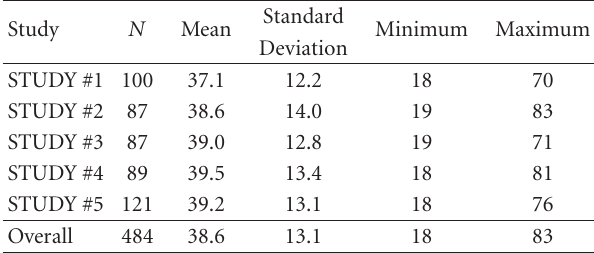
Table 1: Age in years by study.